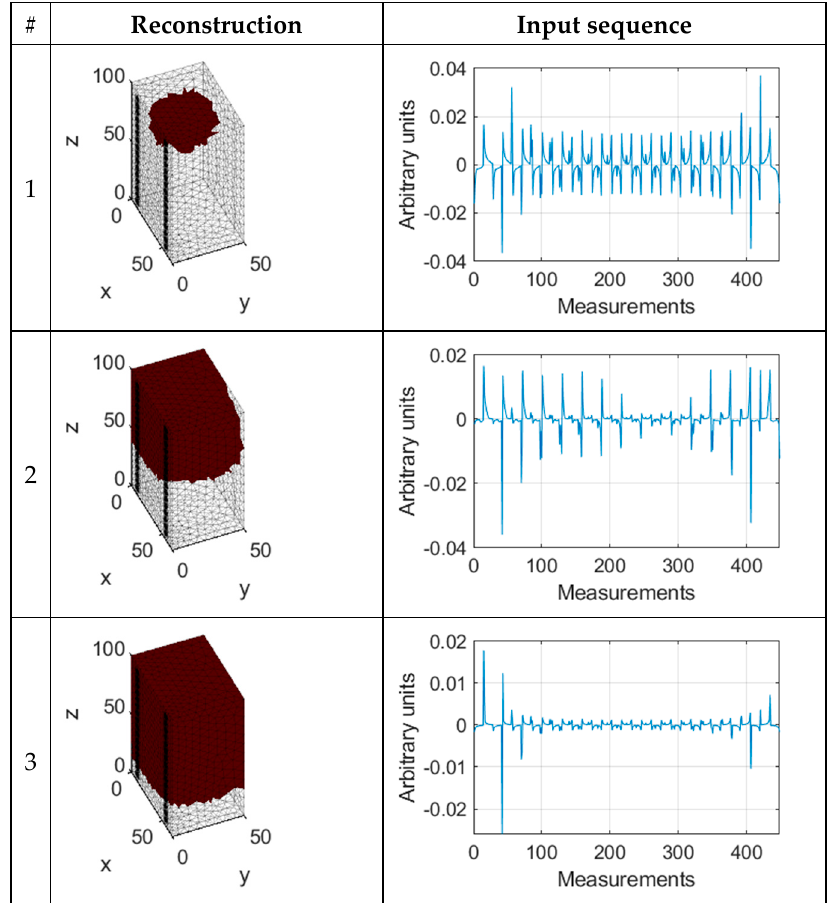
Figure 20. EIT measuring sequences.